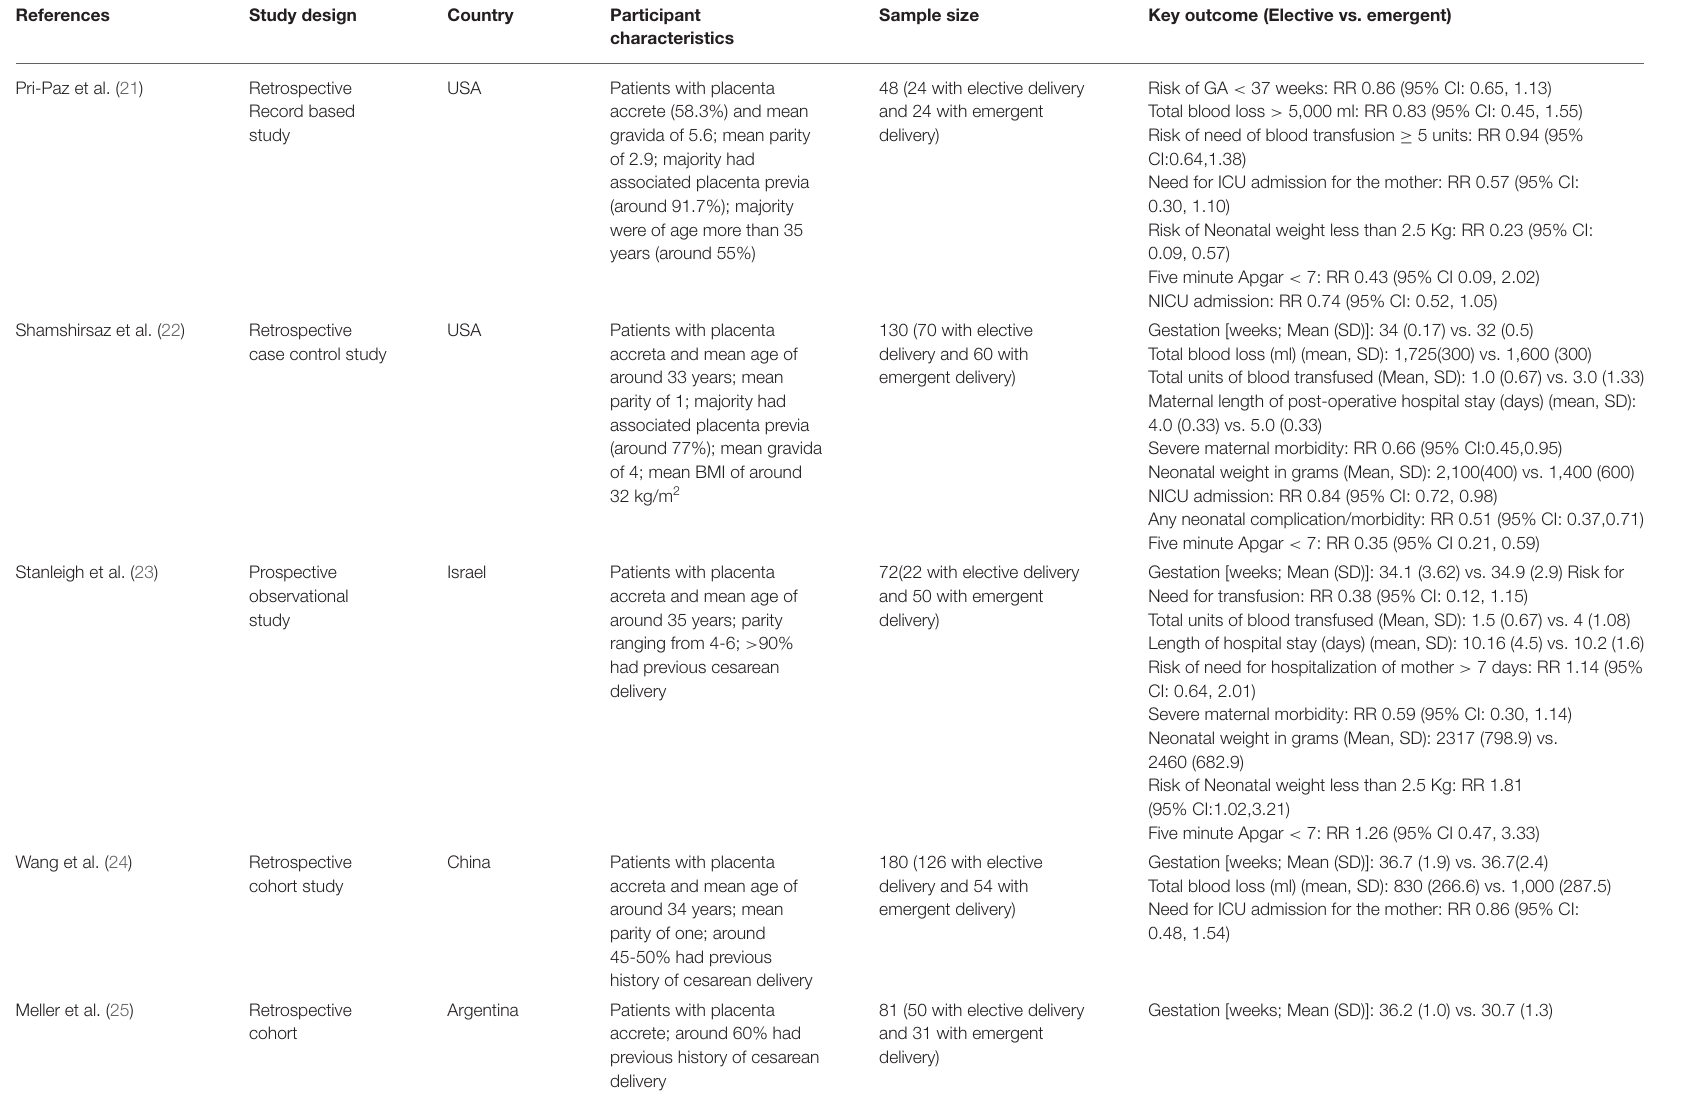
Key outcome (Elective vs.